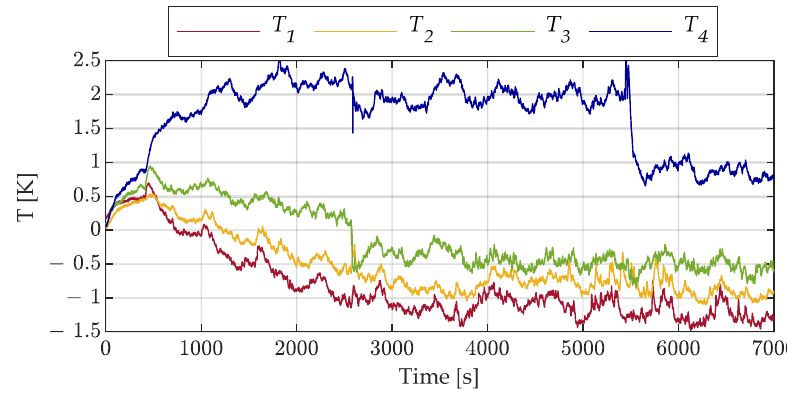
Figure 22. Error test three cells 60 A.